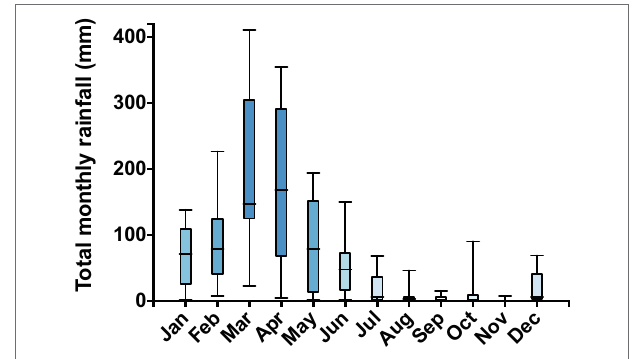
FIGURE 1 | Total rainfall (mm) for each month from 2005 to 2012 as recorded in the Florânia meteorological station (6 ° 6 ′ 36 ʺ S and 36 ° 48 ′ 36 ʺ W) of the National Meteorological Institute (INMET), the closest station to the collection site. The Caatinga is characterized by a rainy season within the first 3–4 months of the year and high annual variability of total precipitation levels. Data are shown as boxes (from the 25th to the 75th percentiles) and whiskers (from the lowest to the highest value) with the line inside the box marking the